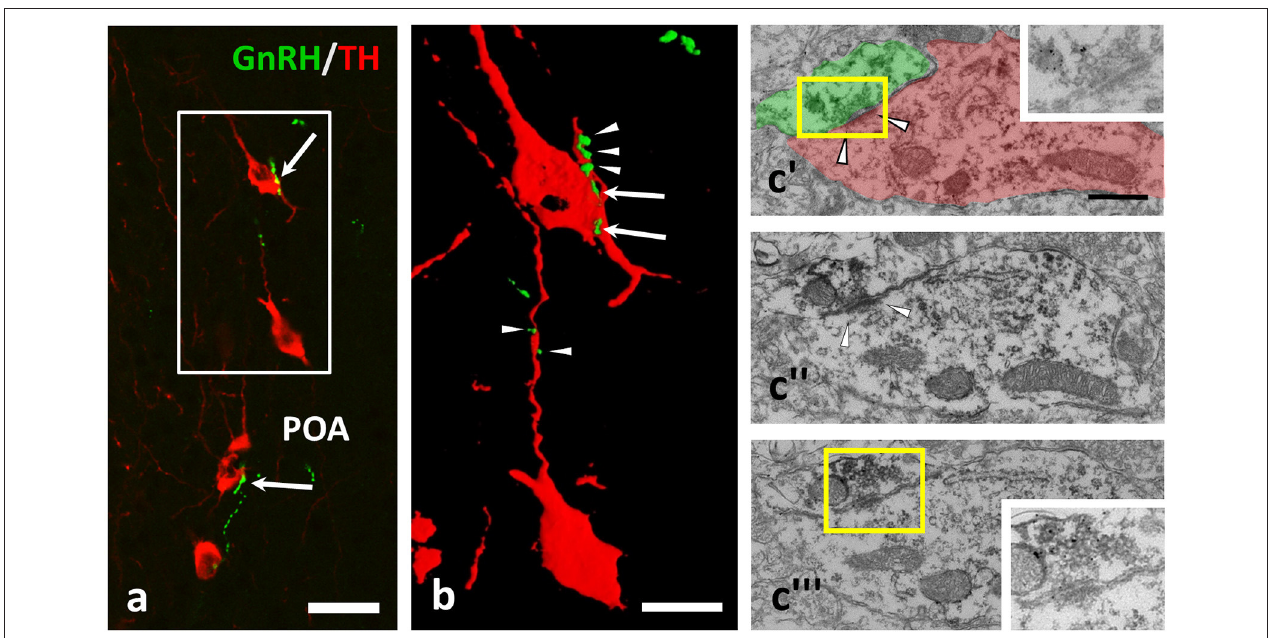
FIGURE 1 | GnRH-immunoreactive (IR) beaded axons contacting processes of TH-IR neurons in the preoptic area of the mouse brain. (a,b) Double immunofluorescent labeling for GnRH (green) and TH (red) shows varicose GnRH-IR fibers in apposition to TH-IR cell bodies (arrows) and dendrites (arrowheads); the gap free connection was validated by reconstructing the image of the immunolabeled profiles in 3D (b) . Using medium electron dense DAB to label TH-IR neurons and highly electron dense SGI-NiDAB to mark GnRH-IR axons in pre-embedding immuno-electron microscopy, (c) asymmetric synapses (arrowheads) were identified. The presence of silver grains and the asymmetric character of the synapse were validated in consecutive ultrathin sections (c ’– c) ”’. Insets in c ’ and c ”’ demonstrate the boxed areas at higher power and a reduced contrast. Scale bar in (a) is 25 µ m; in (b) it is 10 µ m and in (c ’– c) ”’ 500nm.